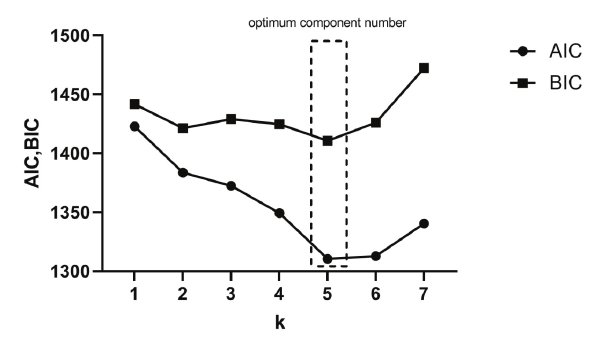
Figure 4. AIC and BIC values versus component number